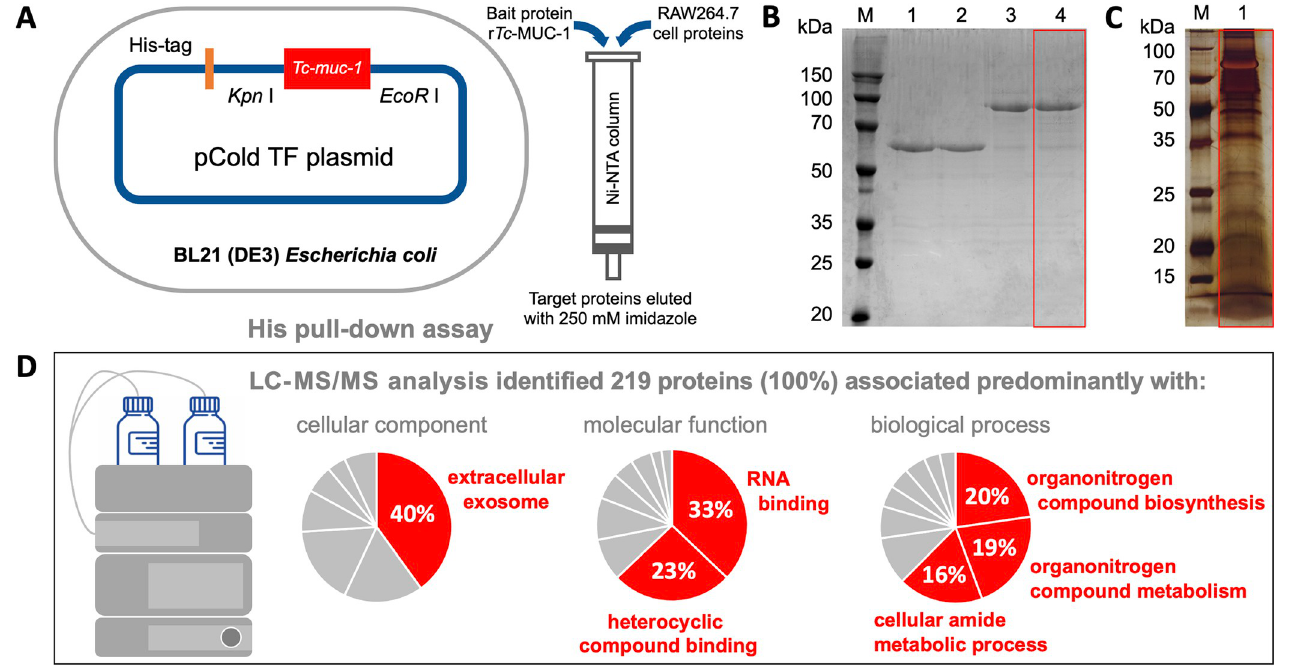
Fig 2. Pull-down and mass spectrometric analyses to identify proteins in murine macrophages that bind recombinant Toxocara canis mucin 1 (r Tc - MUC-1). ( A ) Prokaryotic expression of His-tagged bait protein (r Tc -MUC-1) and elution of proteins of RAW264.7 macrophages bound to a Ni-NTA column. ( B ) SDS-PAGE analysis of r Tc -MUC-1 and proteins pulled down by r Tc -MUC-1. M: protein marker; Lane 1: Empty His-tag peptide (~ 55 kDa); Lane 2: proteins of RAW264.7 cells targeted by the empty His-tag peptide; Lane 3: purified r Tc -MUC-1 fused to His-tag peptide (~ 75 kDa); Lane 4: proteins of RAW264.7 cells targeted by purified His-tag fused rTc -MUC-1 (red box indicated). ( C ) Proteins of RAW264.7 cells pulled down by r Tc -MUC-1, and resolved by SDS-PAGE and stained with silver stain (red box indicated). ( D ) LC-MS/MS analysis of proteins pulled down by r Tc -MUC-1. Peptides and proteins identified as well as the predominant functional predictions (cellular component, molecular function and biological processes) are indicated.